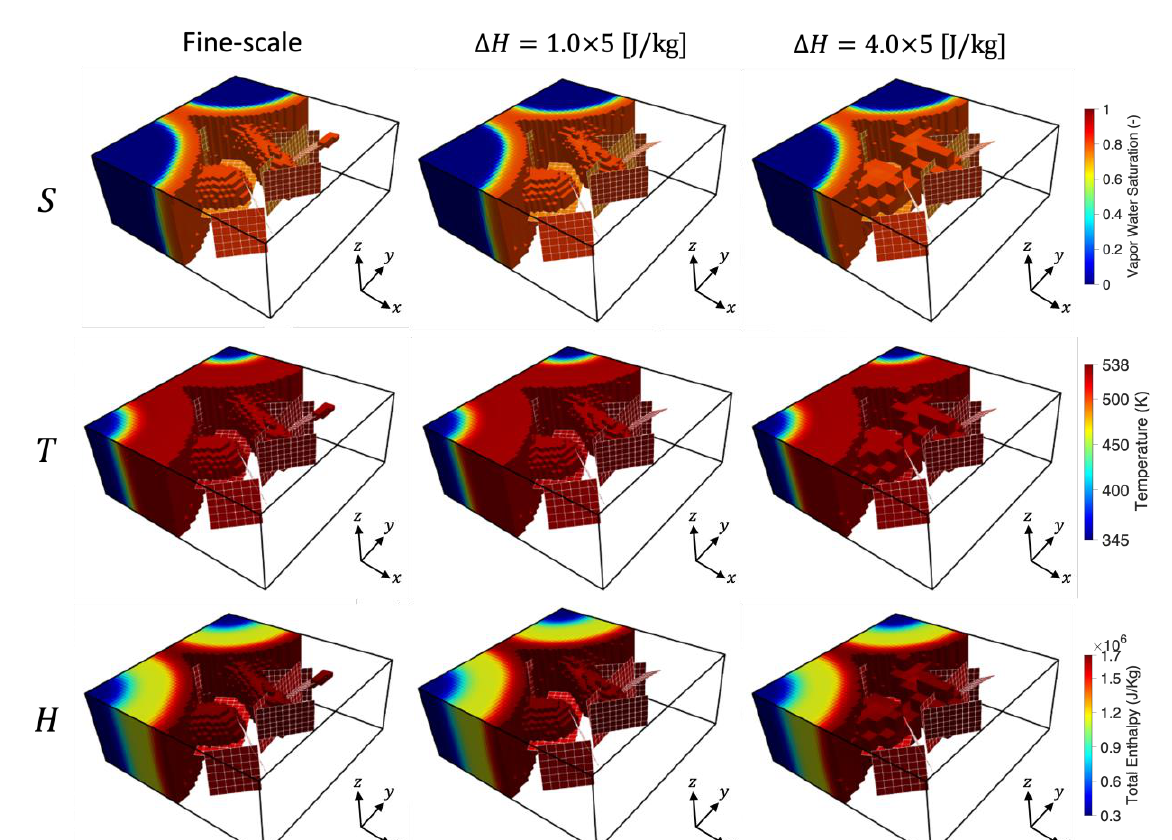
Figure 8. Fine-scale and ADM results from the tolerances of ∆ H = { 1.0,4.0 } × 10 5 [J/Kg]. Starting from the top row to the bottom row, the results of saturation, temperature, and total enthalpy are presented. Note that for better visualization, only a portion of grids in the solutions are visible.